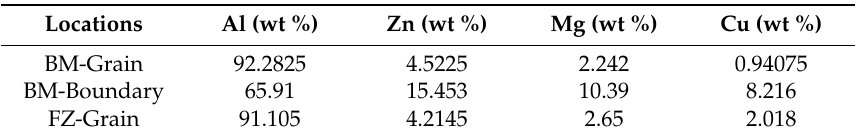
Figure 6. Results of Energy Dispersive X-ray Analysis (EDX) point analysis for: ( a ) grains in BM, ( b ) eutectic phase at boundaries, ( c ) grains in FZ. Table 2. Weight percent of alloying elements at different points of microstructure. Reported numbers are the average of at least three